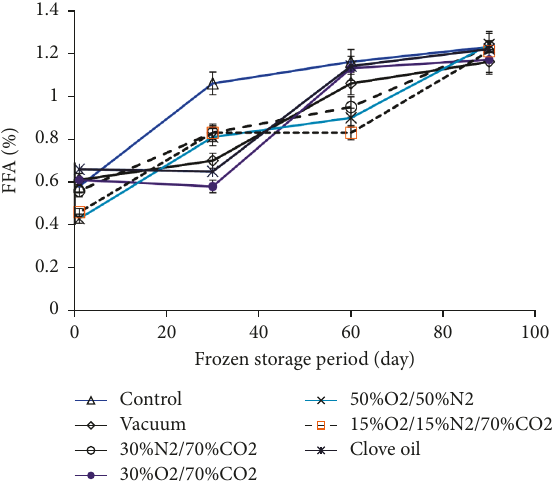
Figure 5: Free fatty acids (FFA) vs. MAP treatments and FSP.